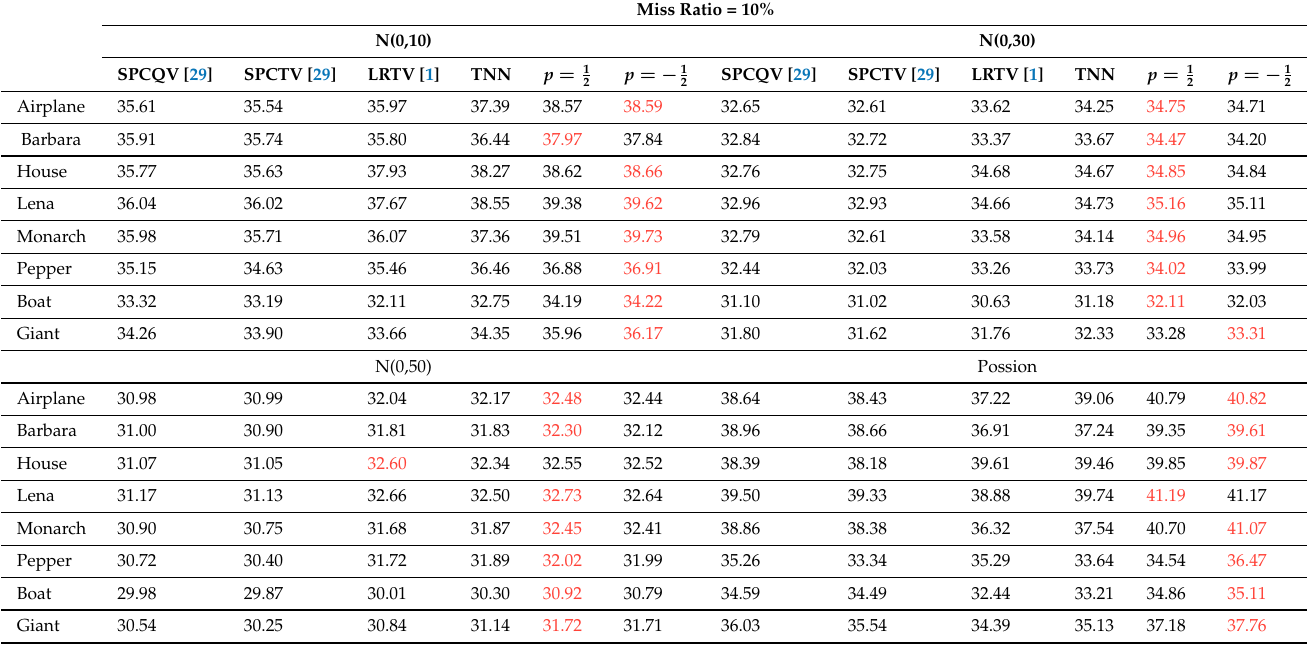
Figure 5. Comparison of damaged image restoration under the 50% missing rate and Poisson noise. In this section, we report the comparison results of PSNR and SSIM of different models when the miss rate is 10% to 50% in Tables 1–4. These tables all contain six kinds of noise conditions. We use red to mark the optimal results between different models, which show that the new model has great potentiality in denoising and completion. For instance, when the test images miss 50% elements and add larger variance Gaussian noise, the performance of p = − 1/2 model is better than other methods. Numerically we can directly find that the difference between different p values of our model is small, but much larger than that of TNN-based models.This is consistent with the functional properties of p -TNN, which can discard some low singular values generated by noise and characterize the low rank of the image within a certain range of parameters. Table 1. Comparisons of PSNR for images with 10% missing elements, where red is the best result. Miss Ratio =